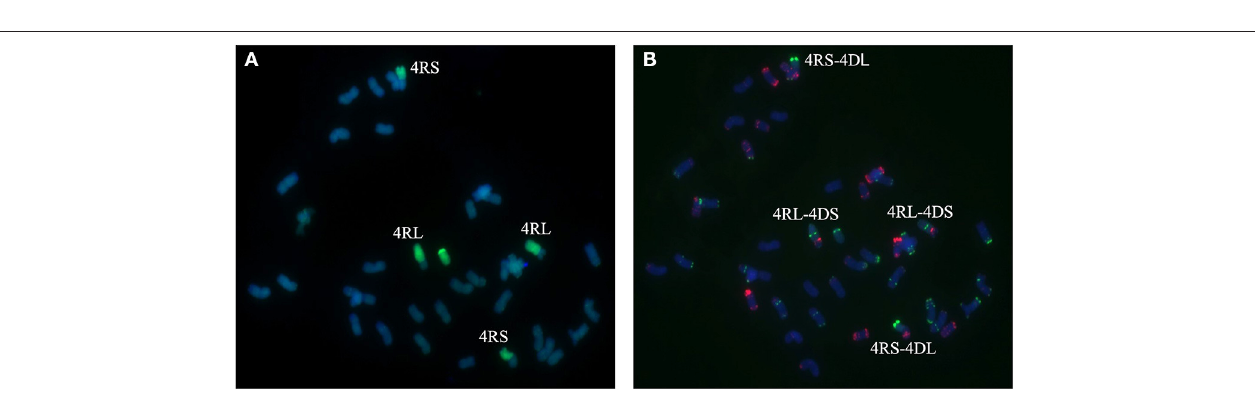
FIGURE 6 | Chromosome composition of BC 2 F 3 line 1204 by FISH (B) and GISH (A) using probe pAs1 (red) and probe pSc119.2 (green). Line 1,204 shows to be a 4R-4D reciprocal translocation in which the short arm of 4R chromosome was translocated to the long arm of 4D chromosome and the long arm of 4R chromosome was translocated to the short arm of 4D chromosome.